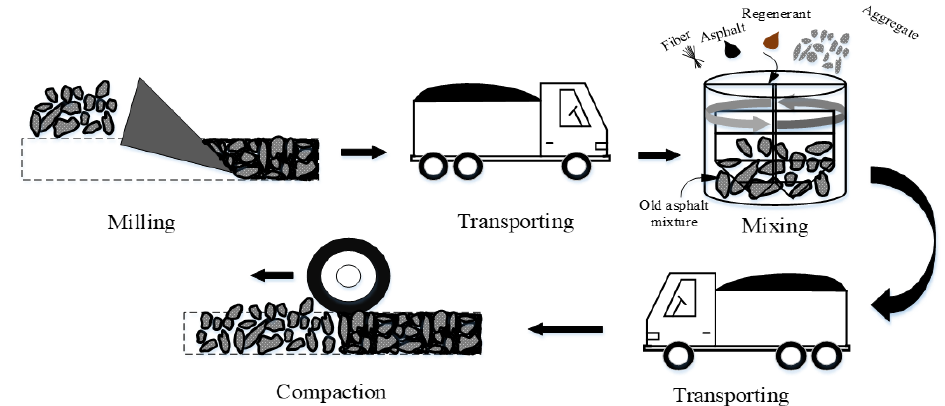
Figure 3. Hot mix plant recycling process.